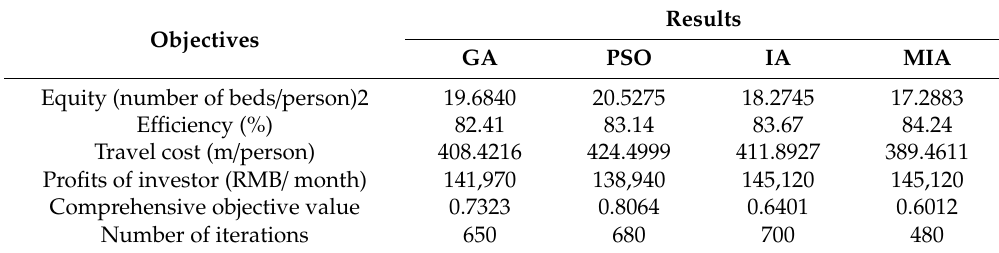
Table 5. Comparison of optimization results obtained by di ff erent